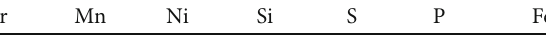
Table 1: The chemical composition of SM480C steels in weight